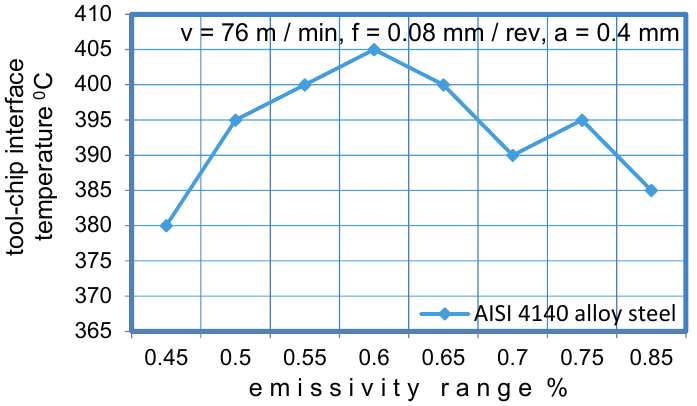
Figure 5. Emissivity range of the IR pyrometer.